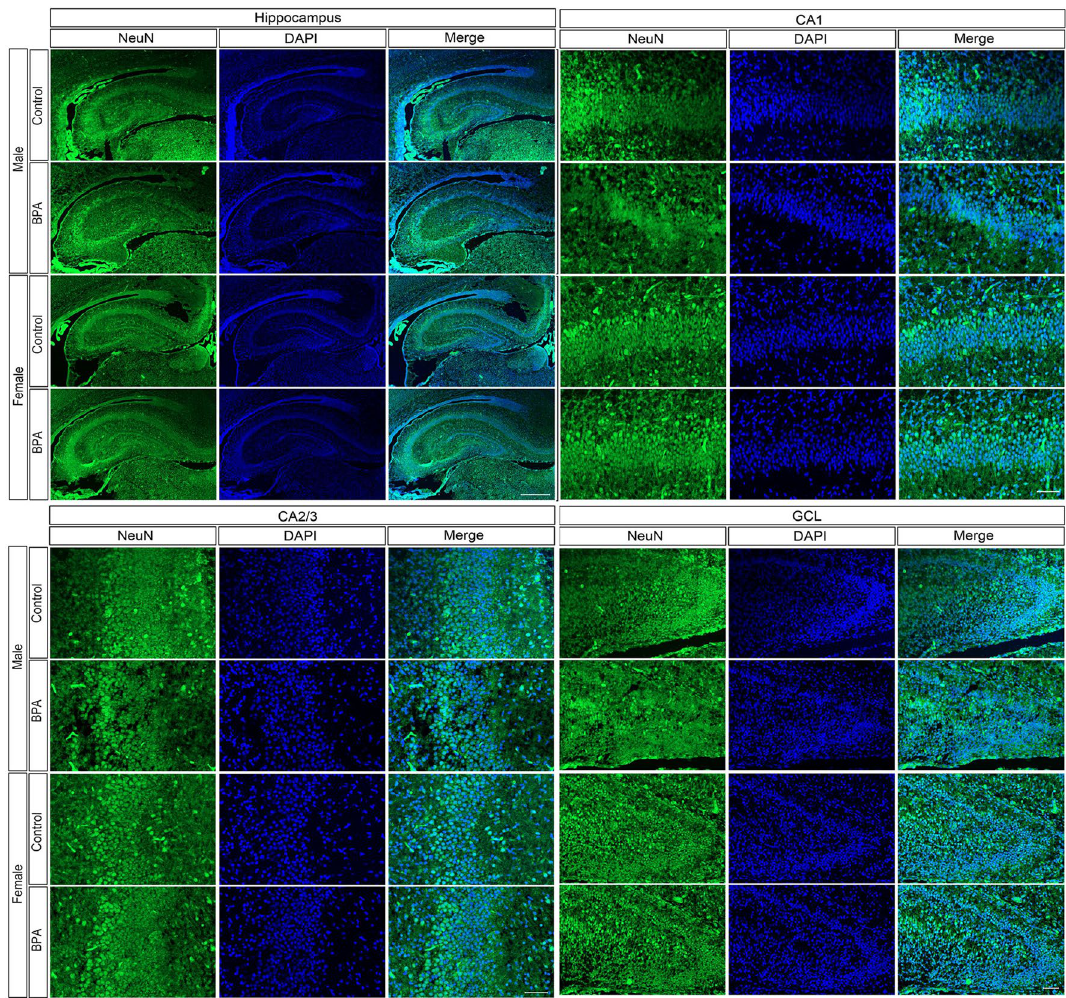
Figure 3. Immunofluorescence images of the hippocampus, CA1, CA2/3, and dentate gyrus of the rat offspring prenatally exposed to BPA or vehicle control. Coronal sections of the offspring hippocampus at PND1 immunostained for NeuN (green) and DAPI (blue). CA1, cornu ammonis 1; CA2/3, cornu ammonis 2/3; GCL, the granule cell layer of the dentate gyrus. Scale bar = 500